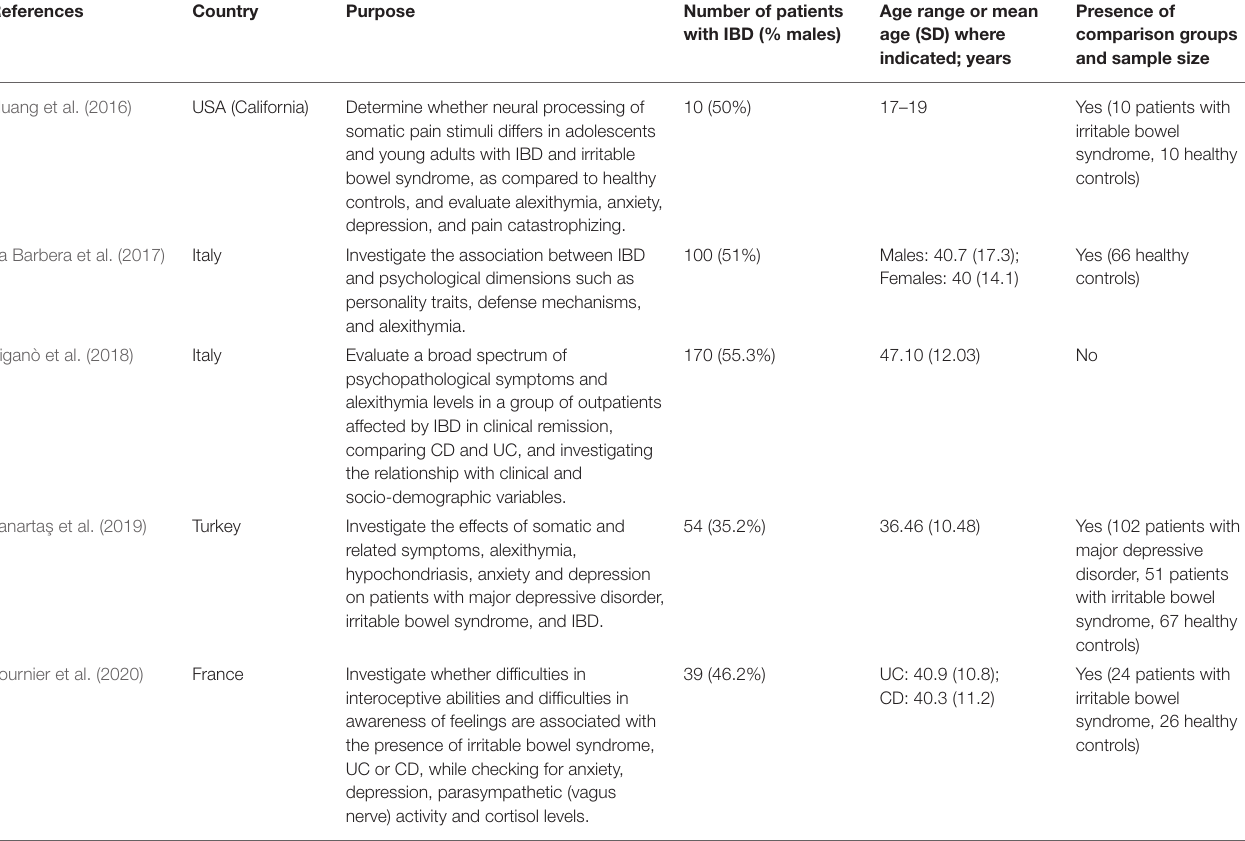
TABLE 1 | Characteristics of included studies (in chronological